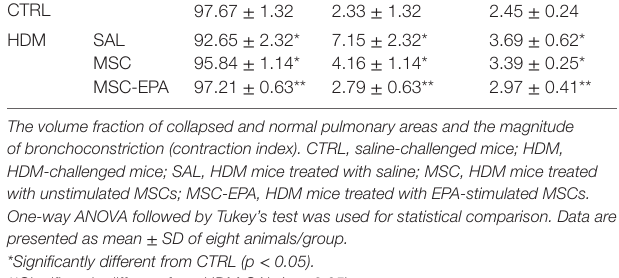
TaBle 1 | Lung morphometry.